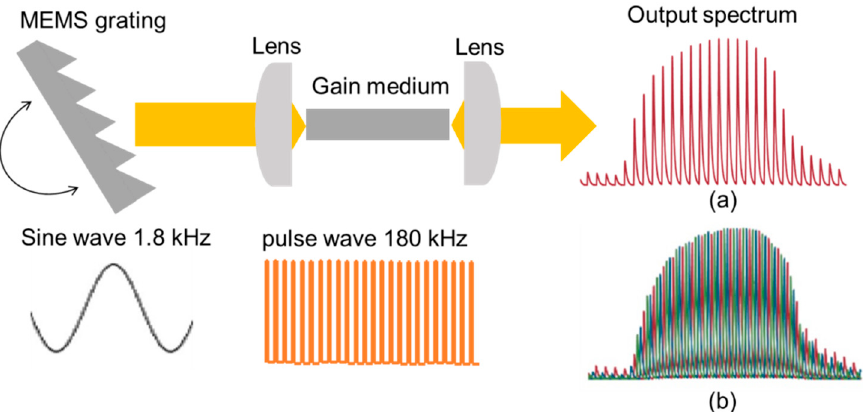
Figure 2. The schematic internal structure of the QCL and examples of output spectrum shape. ( a ) Comb-shaped spectrum shape of a single scan, ( b ) a spectrum shape produced by overlapping comb-shaped spectra with a different phase shift.